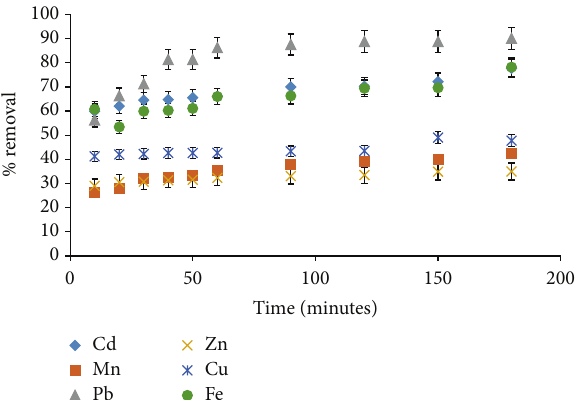
Figure 6: Effect of contact time on selected metal removal using Morula nut (MNS) sorbent (all other variables constant).